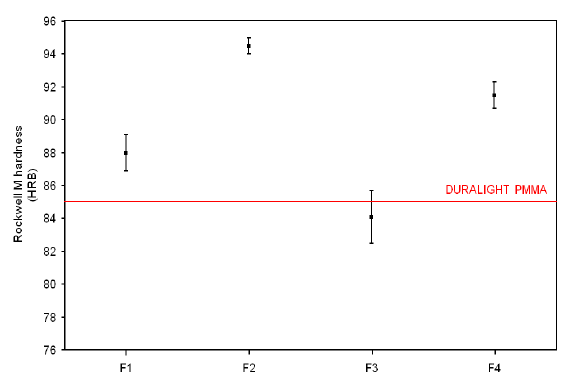
Figure 5. Rockwell hardness results.